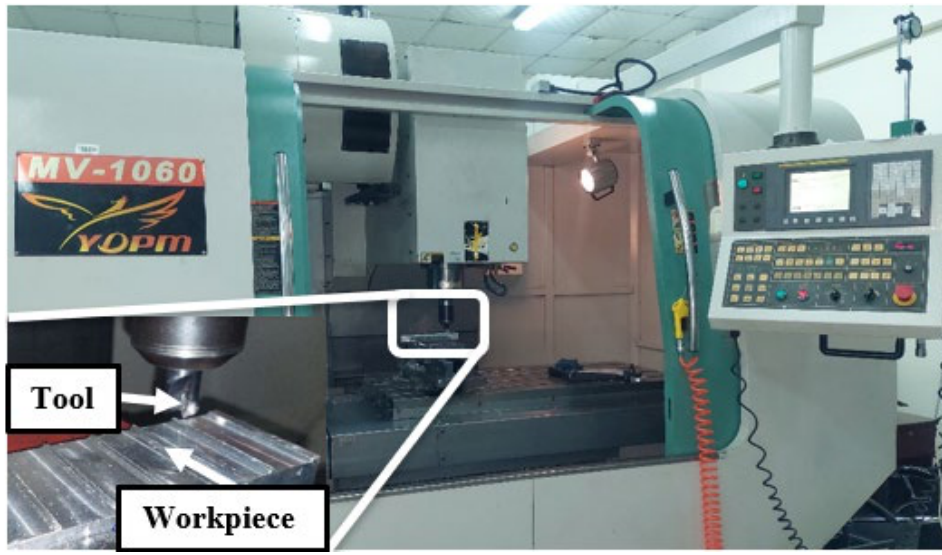
Figure 1. Machining setup.